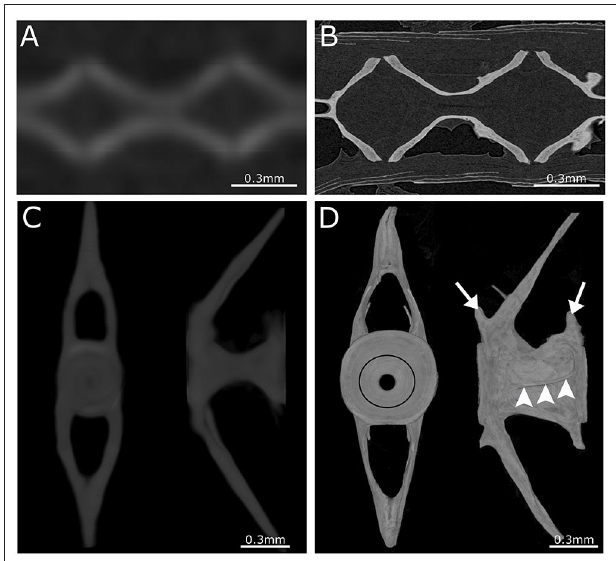
FIGURE 4 | Comparison between low- and high-resolution microCT. (A) Image of parasagittal microCT plane at 21 µ m. (B) Similar structure as in (A) but scanned at 0.75 µ m. Comparison between low-resolution and high-resolution microCT clearly demonstrates the ability to distinguish separate vertebrae and compact bone only using high-resolution microCT. (C) Anterior and lateral view of a 3D maximal projection surface render of a vertebrae scanned at 21 µ m. (D) Similar structure as in (C) but scanned at 0.75 µ m. Notice the difference in detail where the growth rings (black circle) are visible in the vertebral endplate on the anterior view. The lateral view of high-resolution microCT shows the outline of the vertebra with the pre- and post-zygapophyses (white arrows), and an antero-posterior running medial vertebral trabecula (white